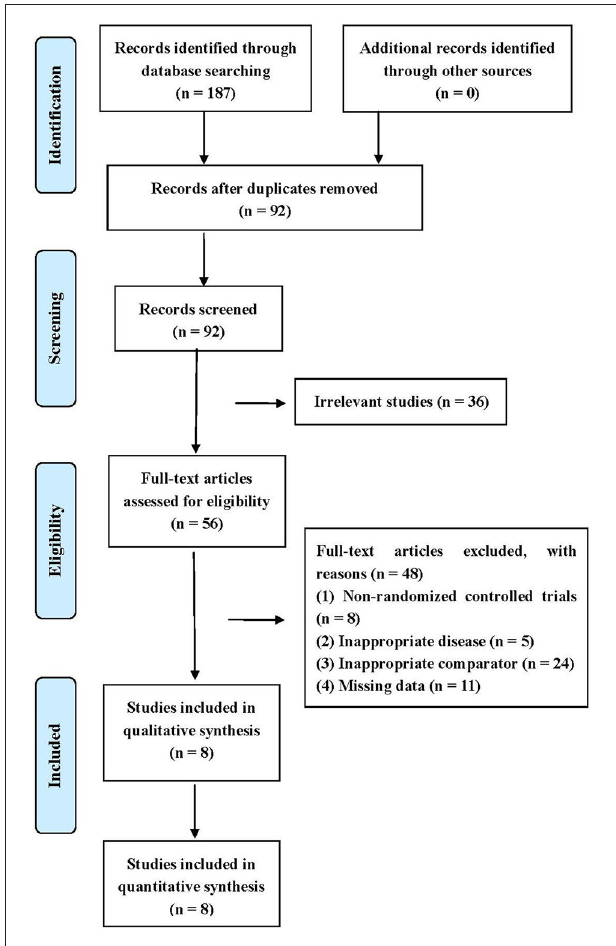
FIGURE 1 | Flow diagram of literature